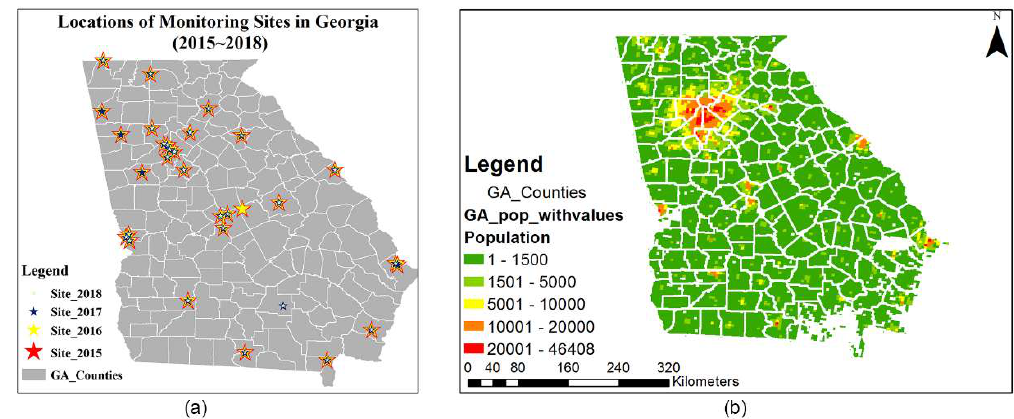
Figure 1. ( a ) Locations of monitoring sites in Georgia: 2015 (red stars), 2016 (yellow stars), 2017 (blue stars), and 2018 (light green stars); and ( b ) distribution (at 4 km resolution) of Georgia’s population (9,687,653) according to the 2010 U.S. Census.